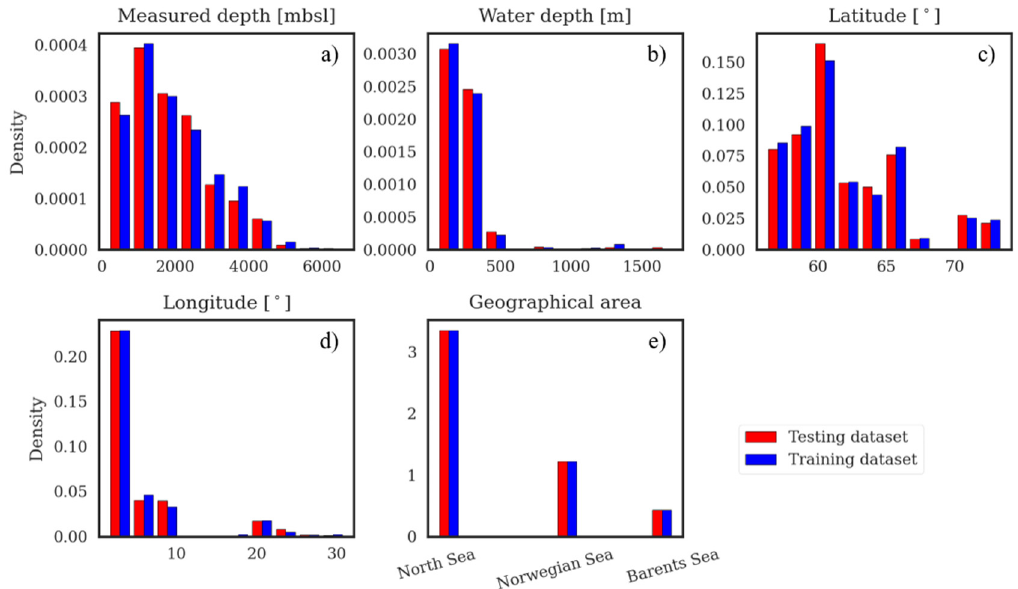
Figure 4. Probabilistic density histograms of training and testing datasets of input variables (left to right): ( a ) depth of measurements (meter below sea level); ( b ) water depth; ( c ) longitude; ( d ) latitude; and ( e ) geographical area.